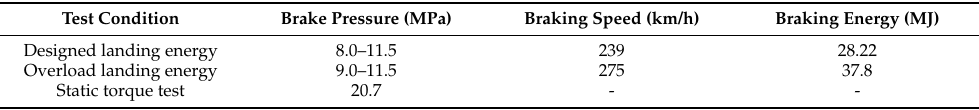
Table 1. Ground dynamic simulation test